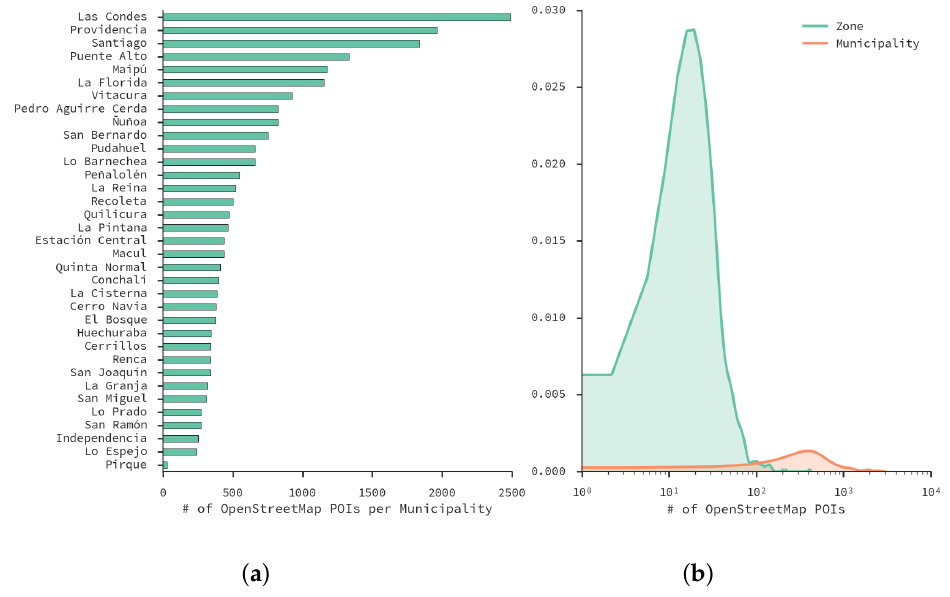
Figure 6. ( a ) number of OpenStreetMap (OSM) venues per municipality in Santiago; ( b ): distributions of the number of venues per designed zone and